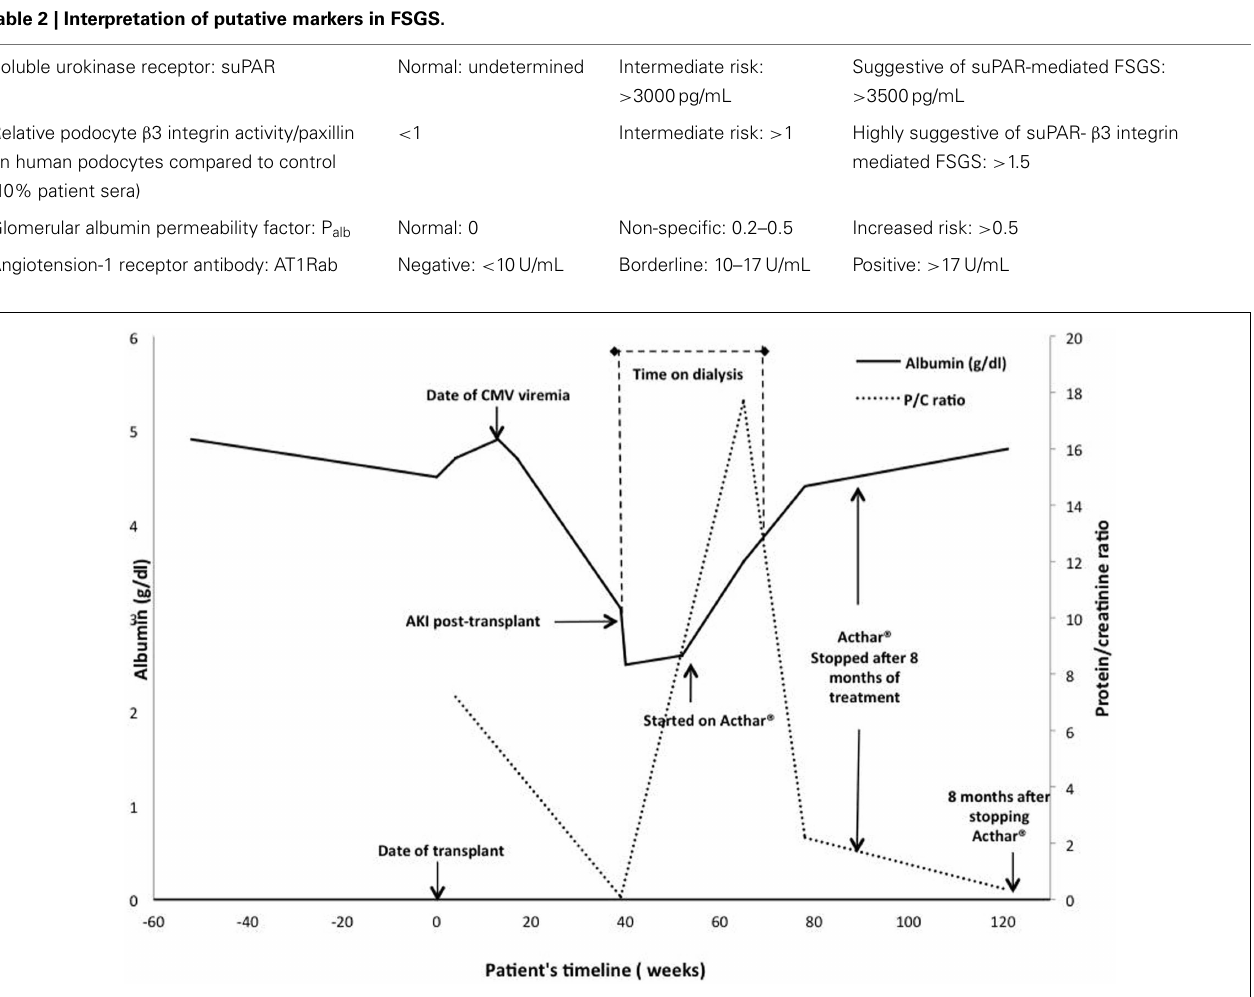
FIGURE 1 | (A) Periodic acid-Schiff stain shows one partially sclerotic glomerulus and two intact glomeruli; there is no tubulitis or interstitial fibrosis; minor tubular epithelial cell changes are noted ( × 200). (B) Electron